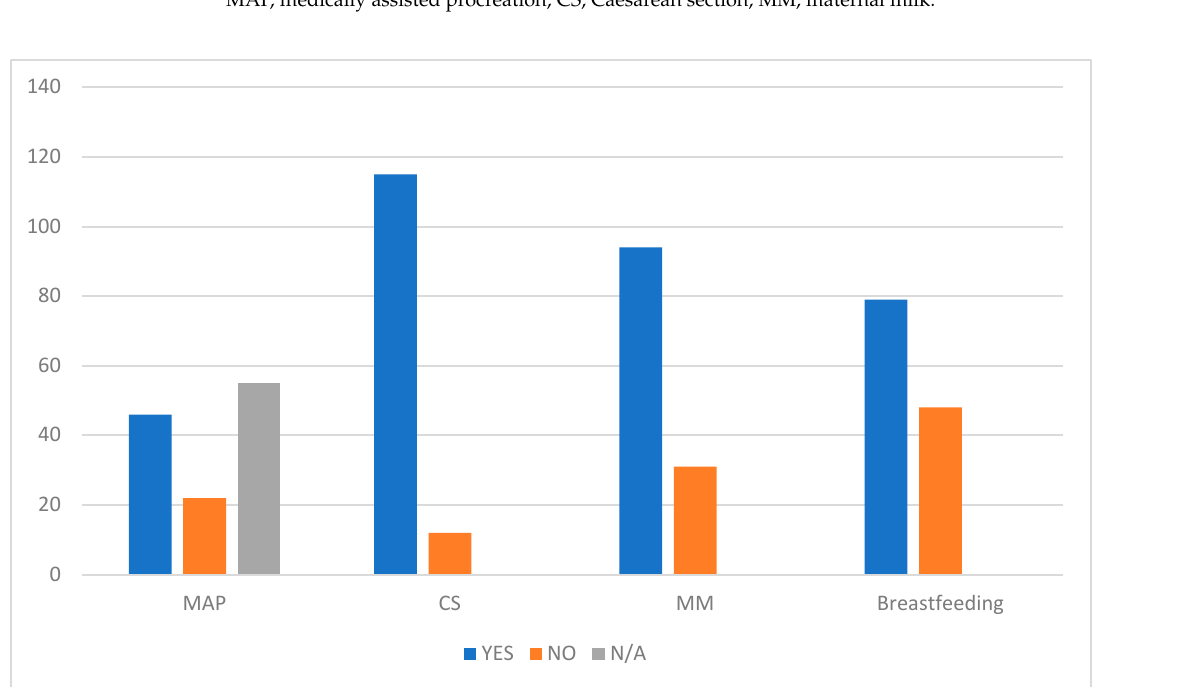
12.6 Figure 4: Population data. Distribution by weight